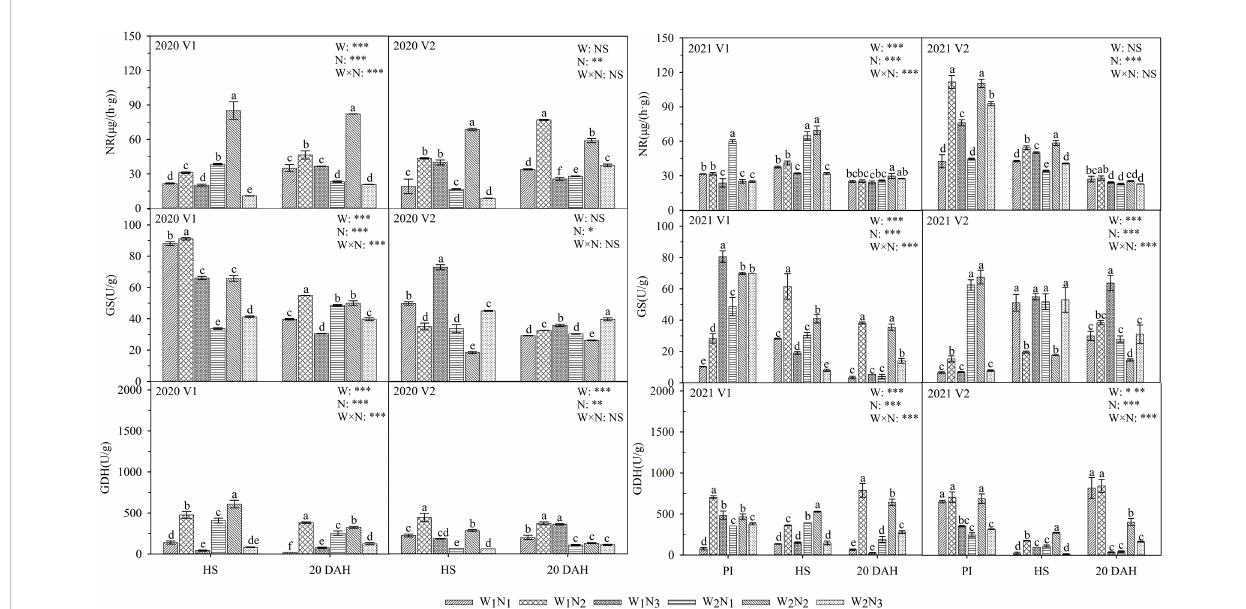
FIGURE 3 Effects of different water and nitrogen treatments on N metabolism enzyme activities in rice leaves at different growth stages. The data are presented as the means of three replicates (n = 3). Error bars indicate standard error (SE). W 1 and W 2 represent limited irrigation (10200 m 3 ·hm -2 ) and de fi cit irrigation (8670 m 3 ·hm -2 ), while N 1 , N 2 , and N 3 represent different ratios of seedling fertilizer:tillering fertilizer:panicle fertilizer:grain fertilizer (30%:50%:13%:7%; 20%:40%:30%:10%; and 10%:30%:40%:20%, respectively). PI, HS, and 20 DAH represent panicle initiation, heading stages, and 20 days after heading, respectively. V1 and V2 represent T-43 and Liangxiang-3, respectively. * represents a signi fi cant difference at the 0.05 level; ** represents a signi fi cant difference at the 0.01 level; *** represents a signi fi cant difference at the 0.001